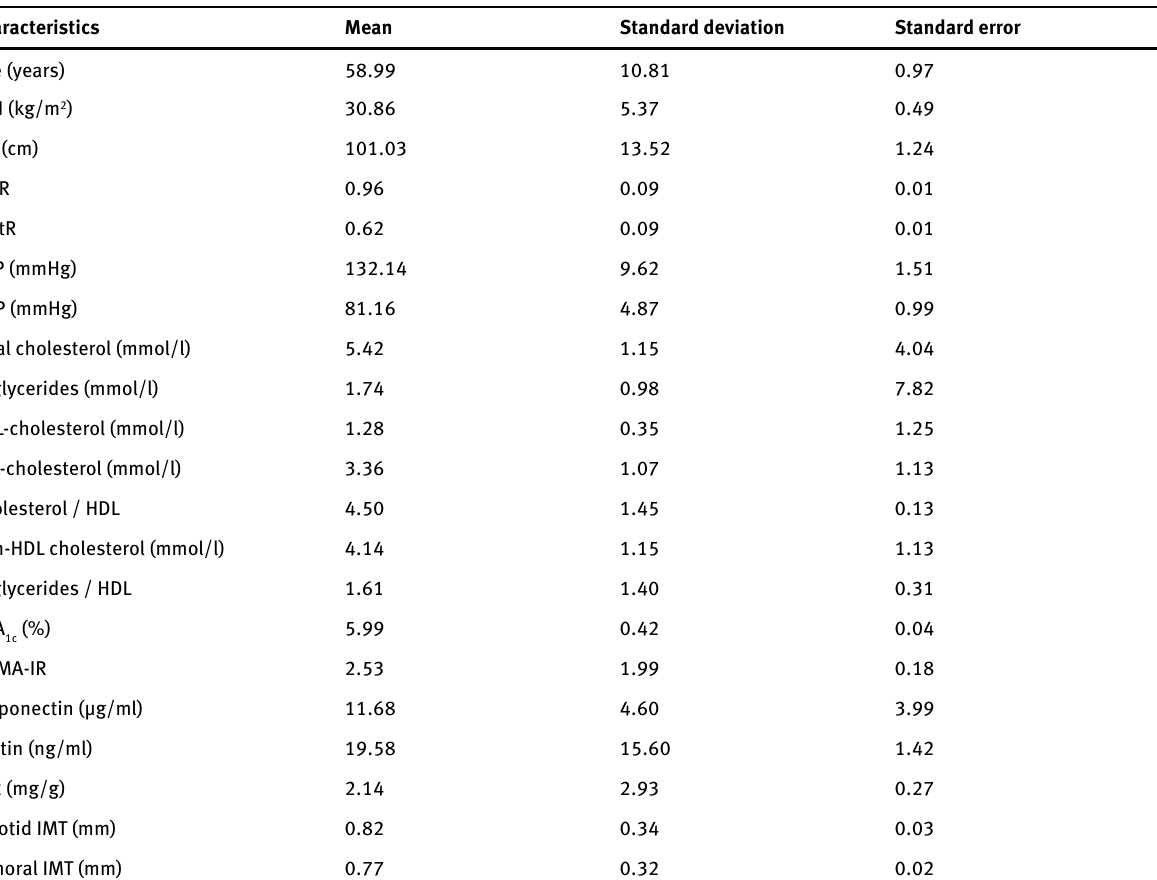
Table 1: Clinical, laboratory and ultrasound characteristics of study subjects